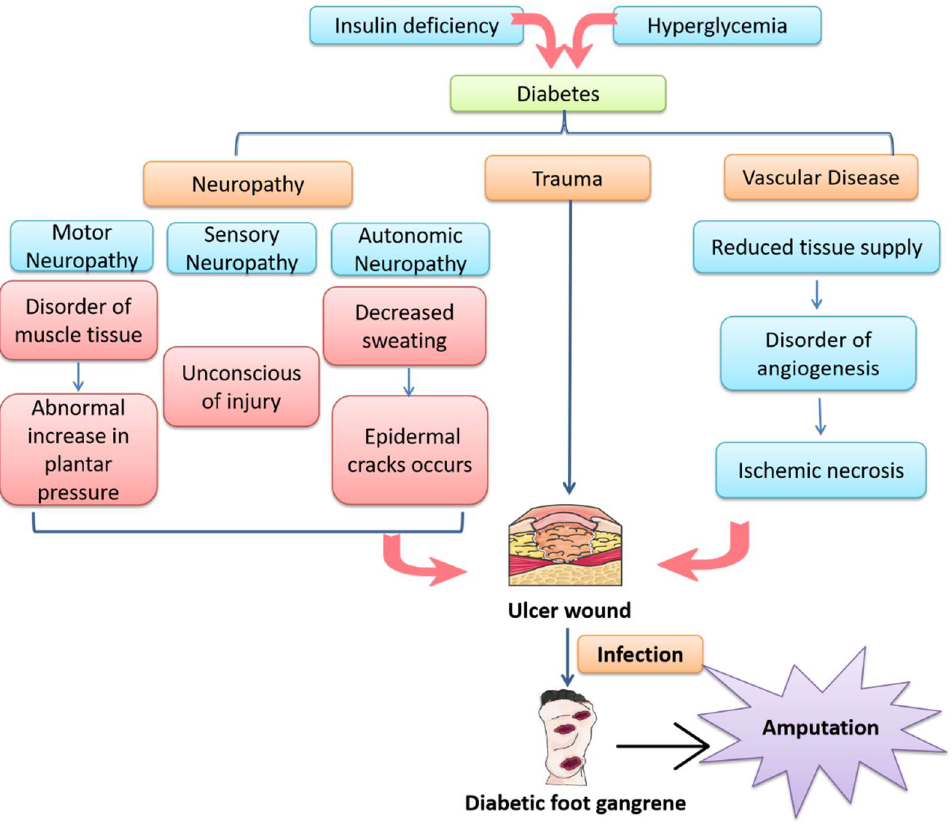
Figure 1. An overview of the pathogenesis of diabetic foot ulcer (DFU). Insulin deficiency and persistent hyperglycemia lead to the development of diabetes mellitus, accompanied by vascular disease and peripheral neuropathy. Motor neuropathy leads to an abnormal increase in plantar pressure, sensory neuropathy makes it difficult for the patient to be aware of wound development and autonomic neuropathy leads to dry, cracked plantar skin. All these factors contribute to the development of DFU. Once DFU occurs, hyperglycemia and an ischemic wound environment promote bacterial proliferation and cause bacterial infection, leading to deep tissue destruction and eventu- ally gangrene. As a result, there is an increased risk of amputation and patient death.